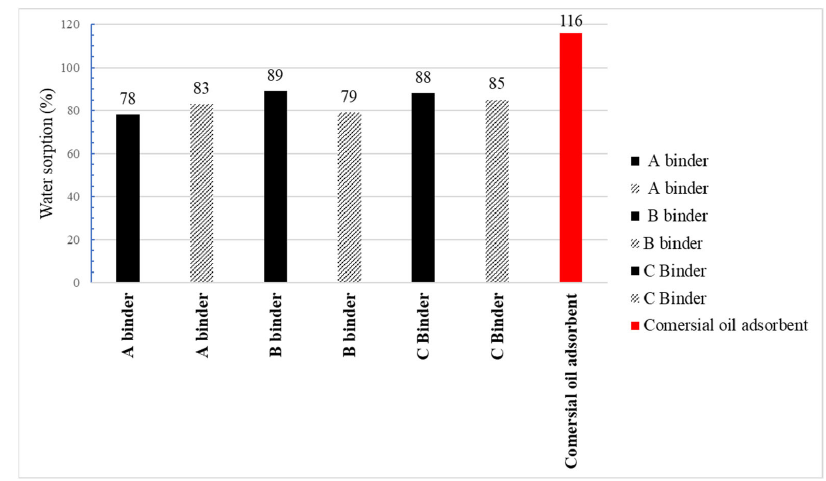
Materials 2022 , 15 , x FOR PEER REVIEW Figure 18. Water sorption agglomerates and commercial adsorbent. Figure 18. Water sorption agglomerates and commercial adsorbent.